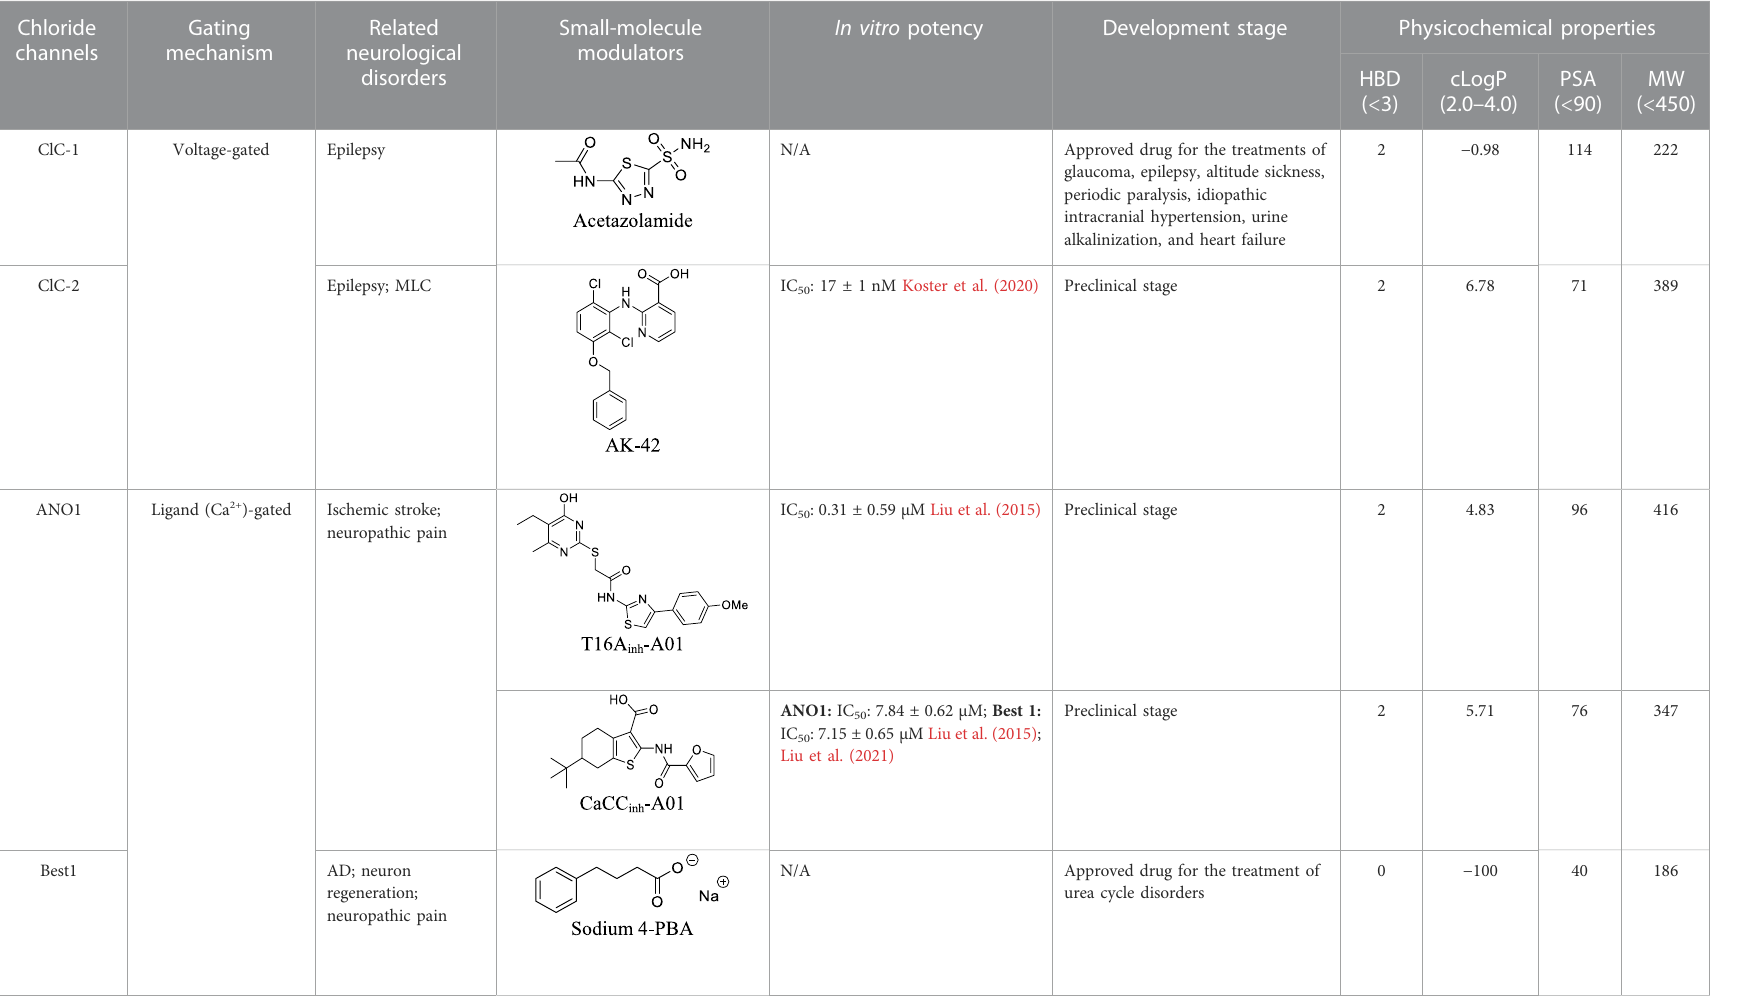
TABLE 1 Summary of chloride channels involved in neurological disorders and their small-molecule modulators with physiochemical